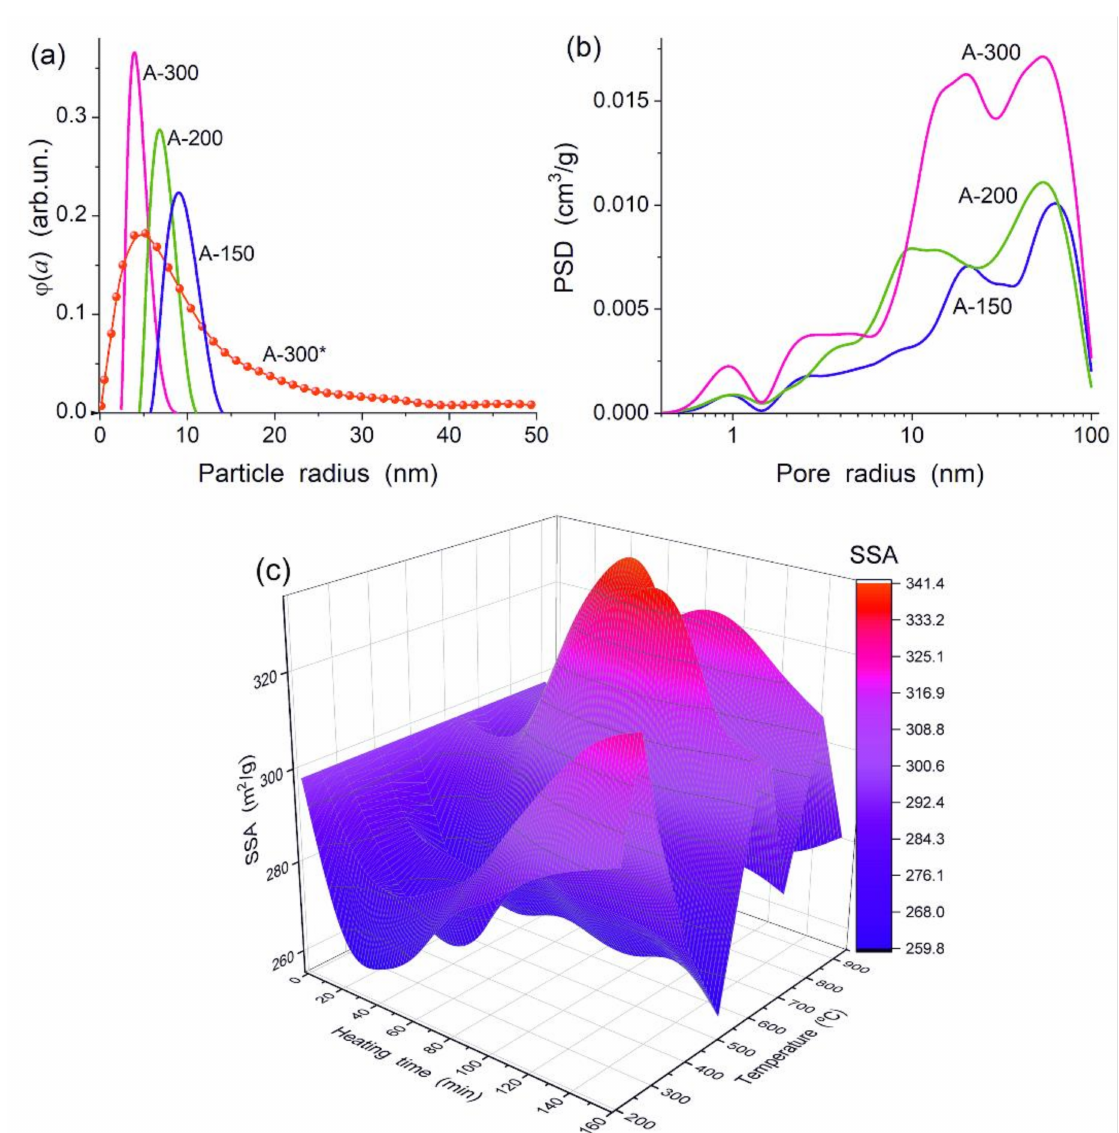
Figure 1. ( a ) Particle size distributions (PaSD) for fumed silica calculated using the nitrogen adsorption isotherms and A-300 PaSD (A-300*) calculated using the small angle X-ray scattering (SAXS [58]) data; ( b ) incremental pore size distributions (calculated nitrogen isotherms with a model of voids between NPNP [59]); and ( c ) specific surface area (using low- temperature Ar adsorption [48]) vs. time and temperature of heating of